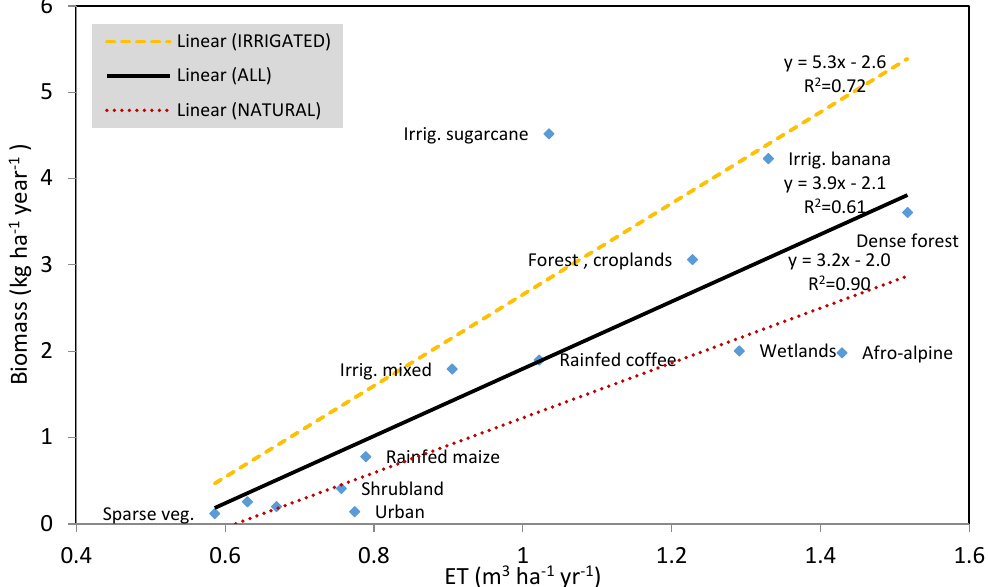
Figure 4. Variation between the biomass and actual evapotranspiration (ET) for agricultural and natural landscapes, using average values, for the period of 2008–2010, in the Upper Pangani River Basin.